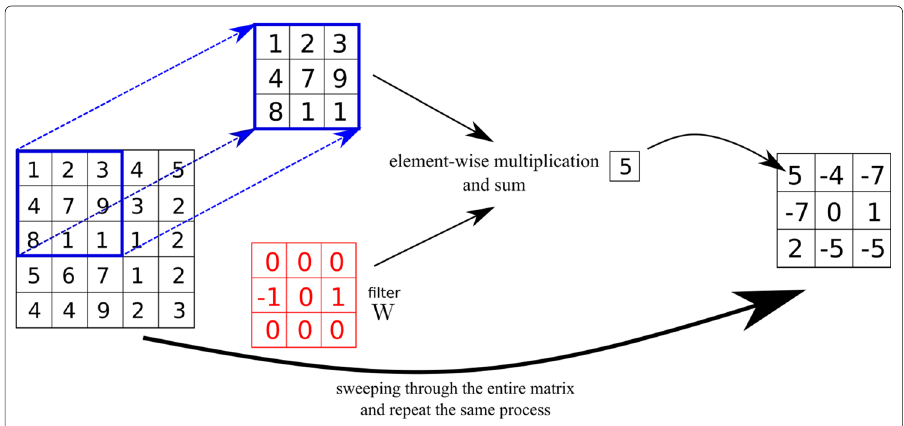
Fig. 2 Illustration of 2D convolution of 3 × 3 kernel W on a 5 × 5 matrix